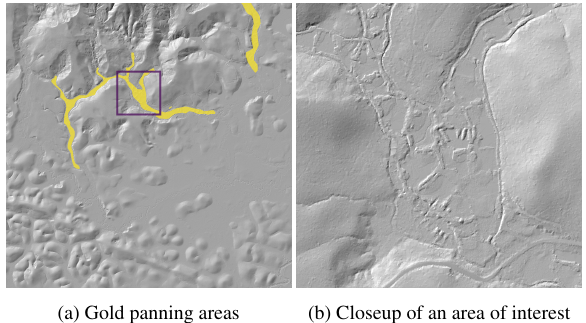
Figure 3. Visualizations of the ground truth used for the experiments. The ground truth is displayed over the hillshades of Fig. 1b. Yellow surfaces are gold panning areas and the purple square is the closeup